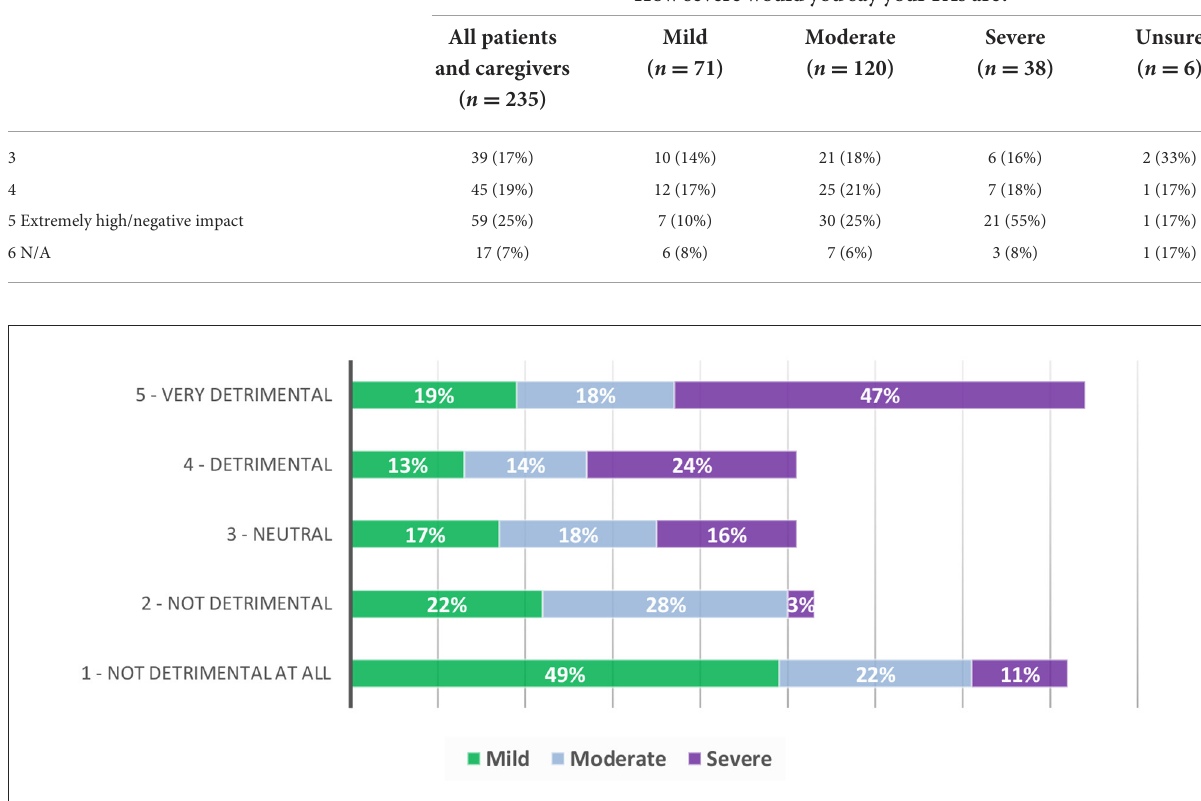
FIGURE2 Perceived Impact of FAs on quality of life in data subjects with mild, moderate and severe FAs.